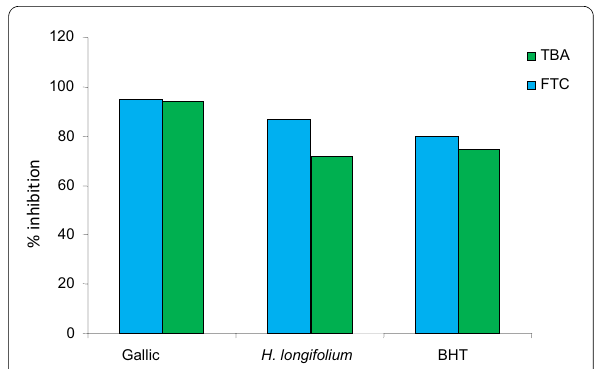
Figure 1 Antioxidant properties of plant extract compared to the standards (Gallic and BHT) as determined with the FTC (500 nm) and TBA (552 nm) methods on the 6th day . TBA : Thiobarbituric acid. FTC : Ferric thiocyanate. BHT : Butylated hydroxyl